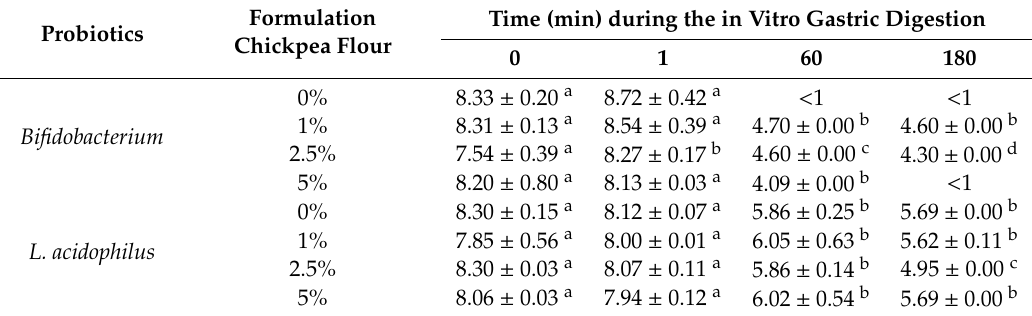
Table 3. E ff ect of simulated gastric juices (pH 2.0) on the viability of probiotics in yogurt